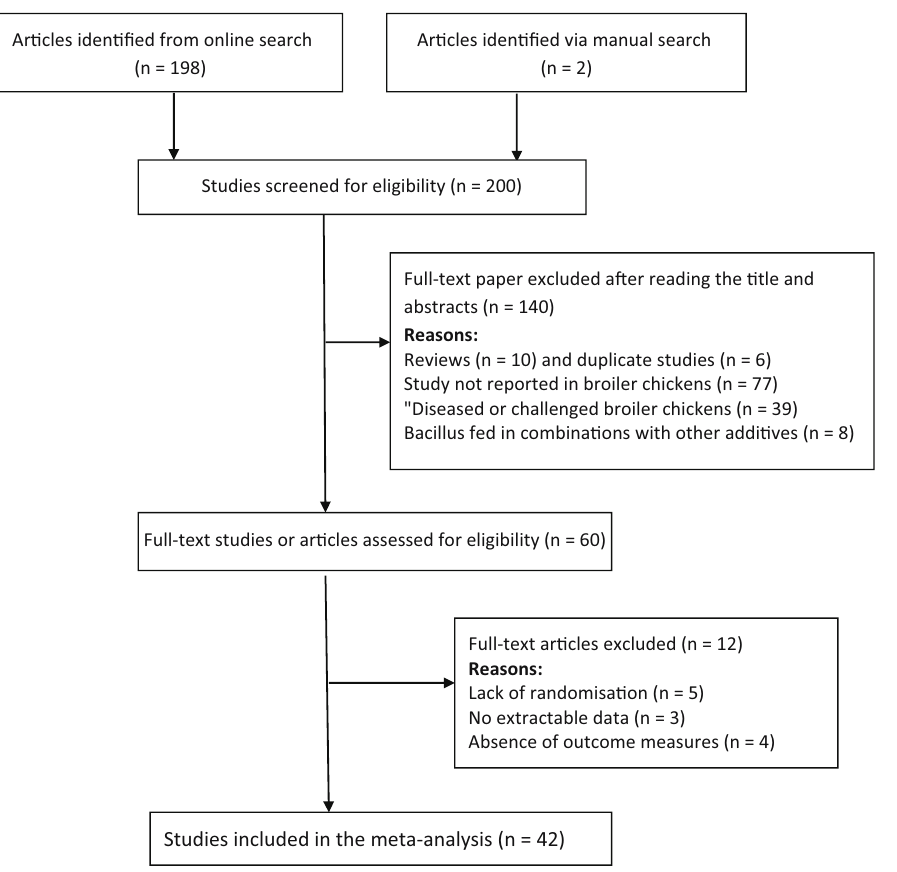
Figure 1: Flow diagram of the paper selection process used for the meta -